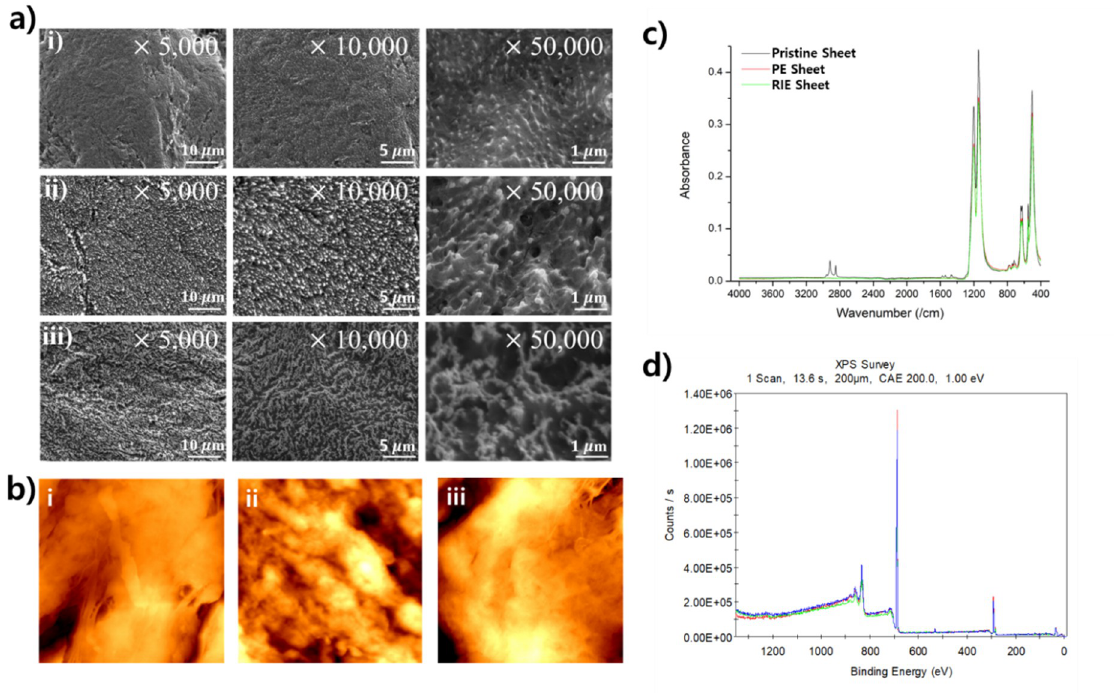
Fig 3. Analysis of surface characteristics. (a) FE-SEM image i) Before treatment, ii) After RIE treatment, iii) After PE treatment. More detailed structures of columnar shapes can be observed on the RIE surface, and leaf vein-like structures can be observed on the PE surface. (b) SPM images of surfaces i) pristine, ii) after PE treatment and iii) after RIE treatment. (c) FT-IR spectrum analysis confirmed no significant difference in the chemical composition of the surface before and after treatment. (d) XPS results of pristine, PE, and RIE